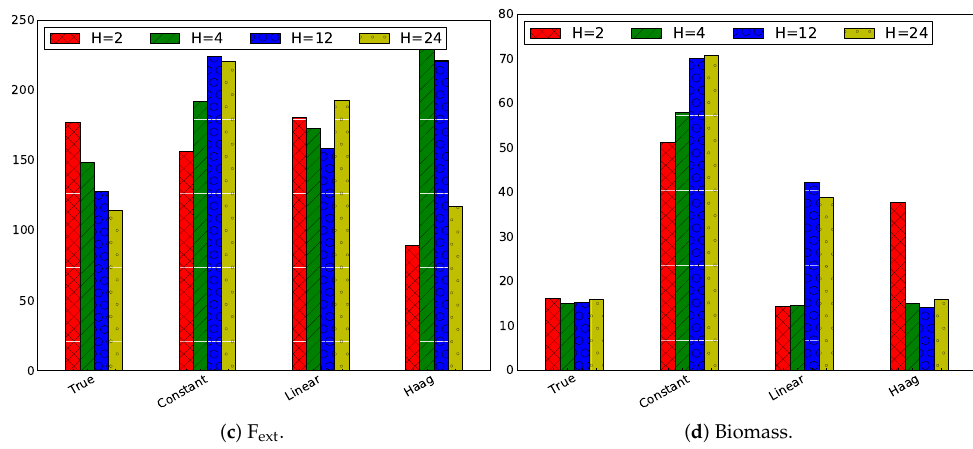
Figure 9. Absolute values of the absolute tracking error in case of H = H e = H p for the four states, i.e., the extracellular metabolite concentrations.